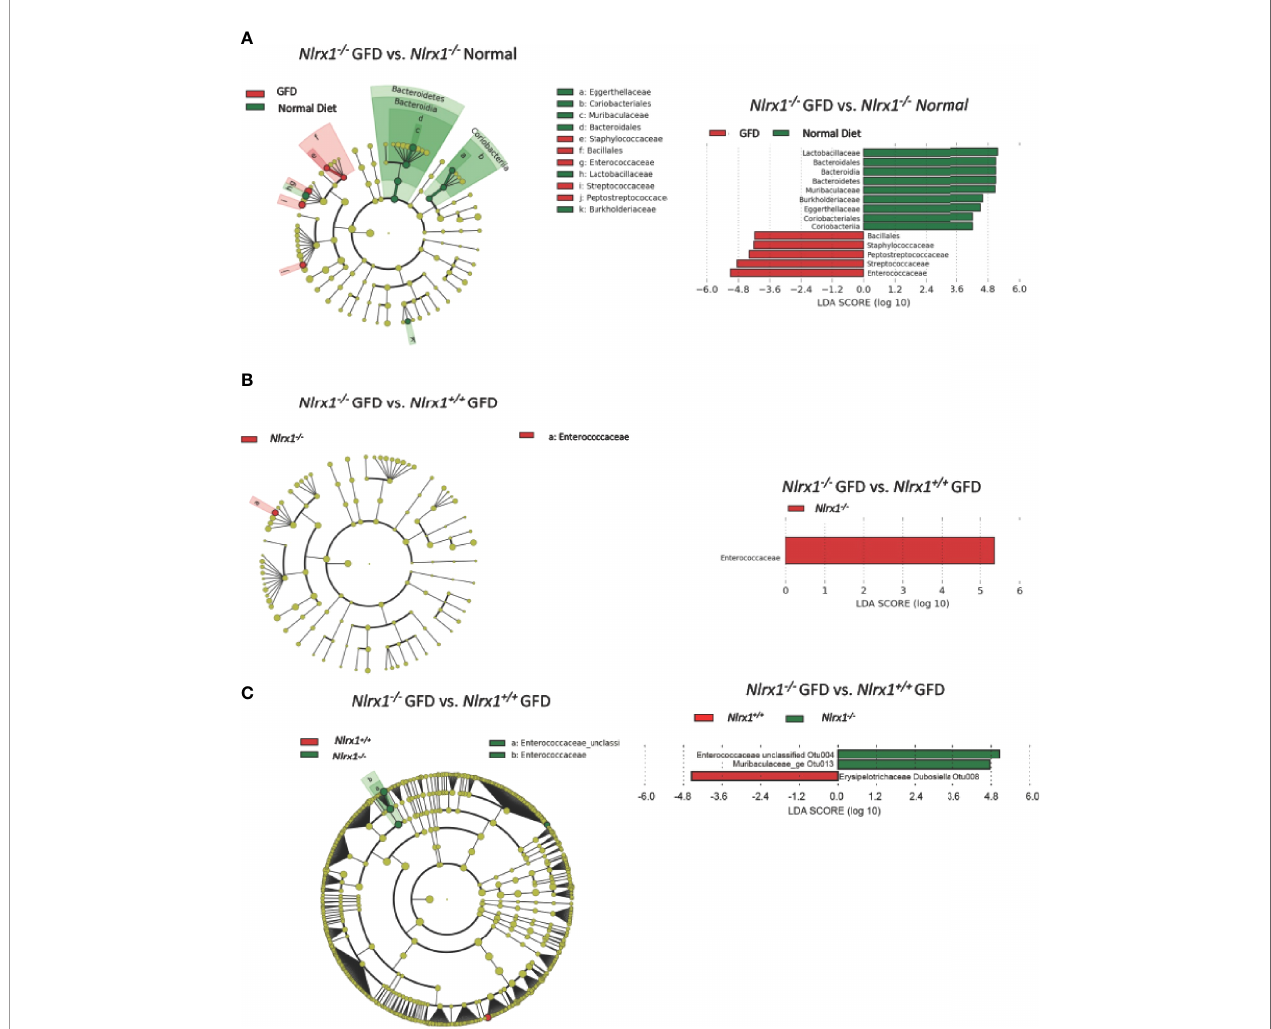
FIGURE 5 | Comparison of the Effects of GFD on the Microbiome of NLRX1-de fi cient Mice. (A) Cladogram displaying differential bacterial abundance in NLRX1 -/- GFD (red) and normal diet (green). LEfSe differential analysis displaying bacterial abundance in in NLRX1 -/- GFD (red) and normal diet reveals signi fi cant differences exist between the microbial populations at the family level. The graph was generated using the LEfSe program. NLRX1 -/- GFD (red). (B) Cladogram and LEfSe analysis displaying differential bacterial abundance in NLRX1 -/- (green) and mice with intact NLRX1 signaling (red) following GFD at family level (C) Cladogram displaying differential bacterial abundance in NLRX1 -/- (green) and mice with intact NLRX1 signaling (red) following GFD at OTU level. LEfSe differential analysis displaying bacterial abundance in in NLRX1 -/- (green) and wild-type mice (red) reveals miniscule differences exist between the microbial populations. The graph was generated using the LEfSe program. n = 7 mice per